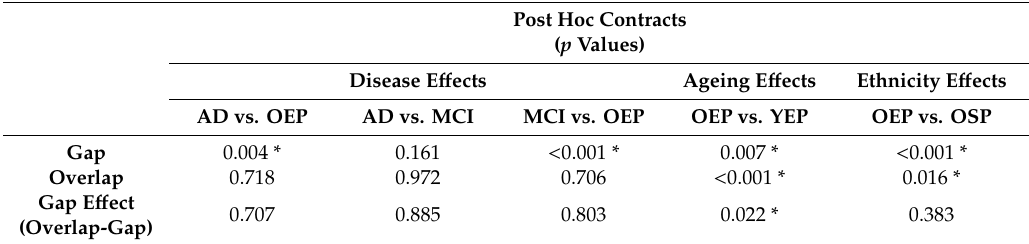
Table 4. Table displaying post hoc comparisons for the prosaccade task gap and overlap conditions.